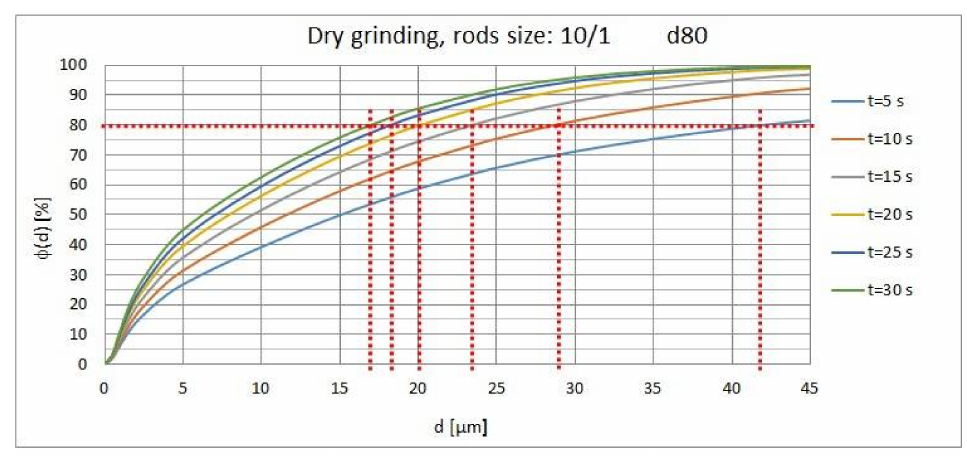
Figure 10. Comparison of d 80 size in the product dry grinding.